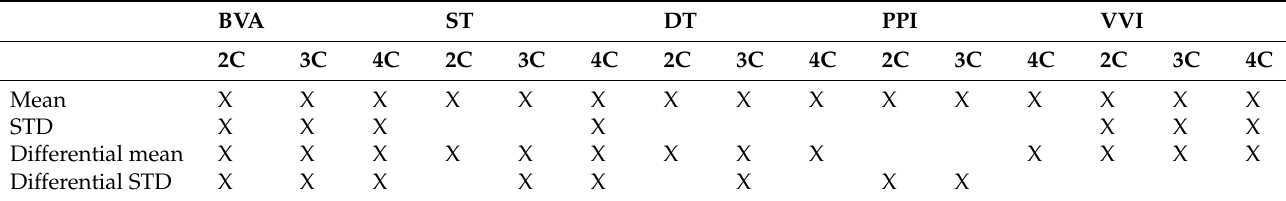
Table 6. Features selected from the 20 combined features using